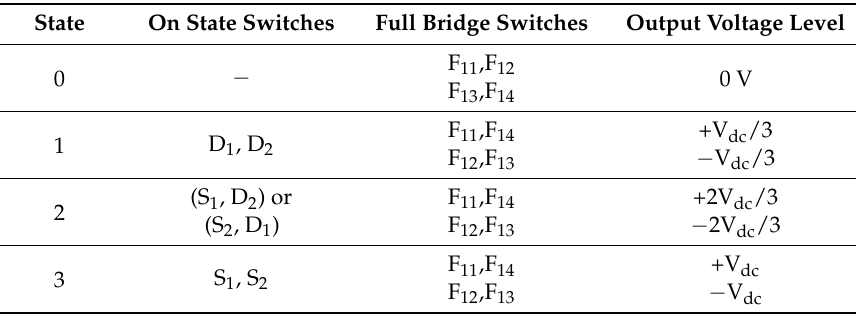
Figure 2. ( a – f ) Various modes of operation of the proposed basic unit. Table 1. Switching sequence for the basic unit.